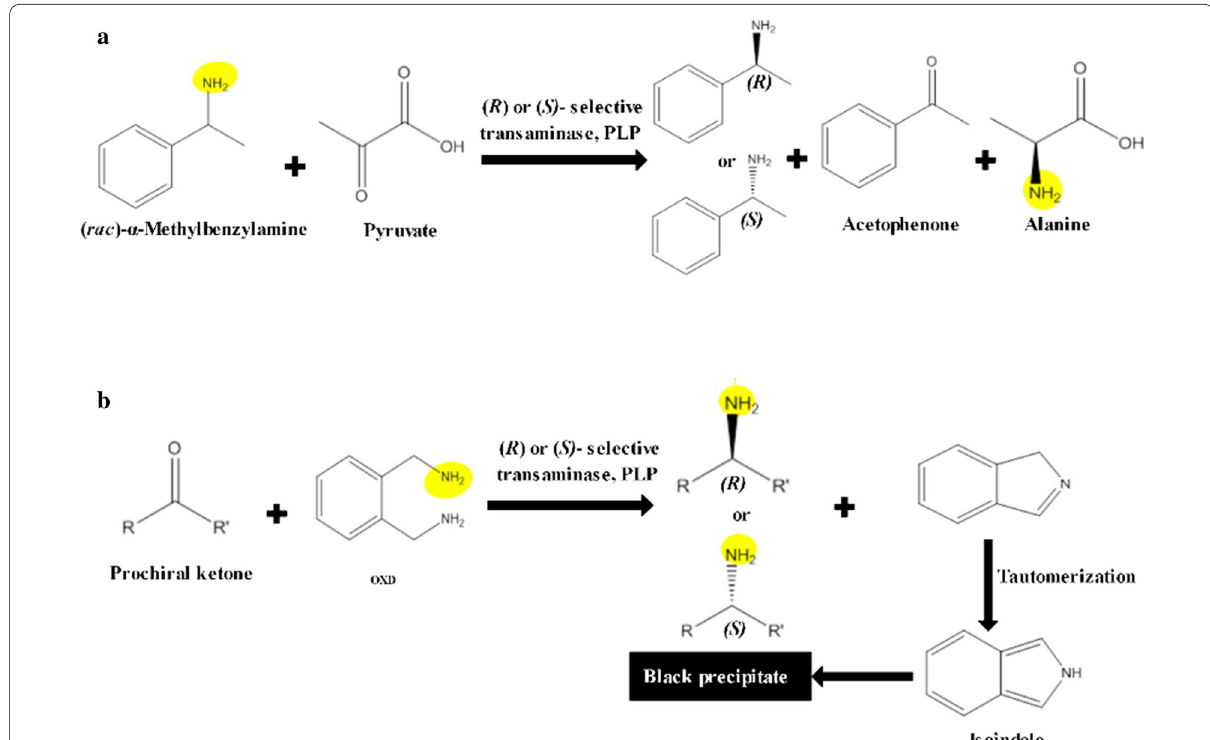
Fig. 1 ω-TA activity towards different substrates. a ω-TA catalyzed reaction of ( rac )-MBA with α-keto acid such as pyruvate. b Color developing process in ω-TA reaction by using ortho -xylylenediamine (OXD) as amine donor. R and R ’ refer to the residues defined by the substrate specifity of the applied enzyme, amine group was highlighted to show how amine group is stereospecifically transferred to the ketone by ω-TA